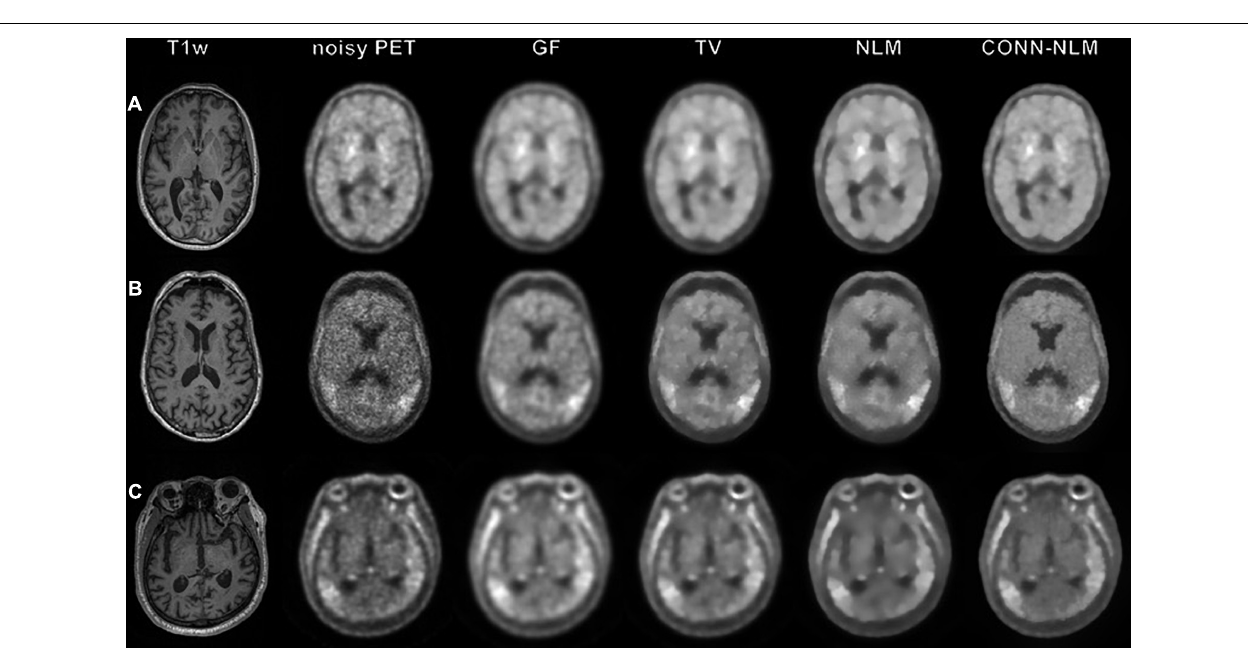
FIGURE 8 | CRC% plotted against the average variance (background and lesion variance combined) for each lesion separately, for the high-count simulated PET data. For each filter, six points were chosen to produce approximately the same range of noise variance, by varying the corresponding filter parameter.